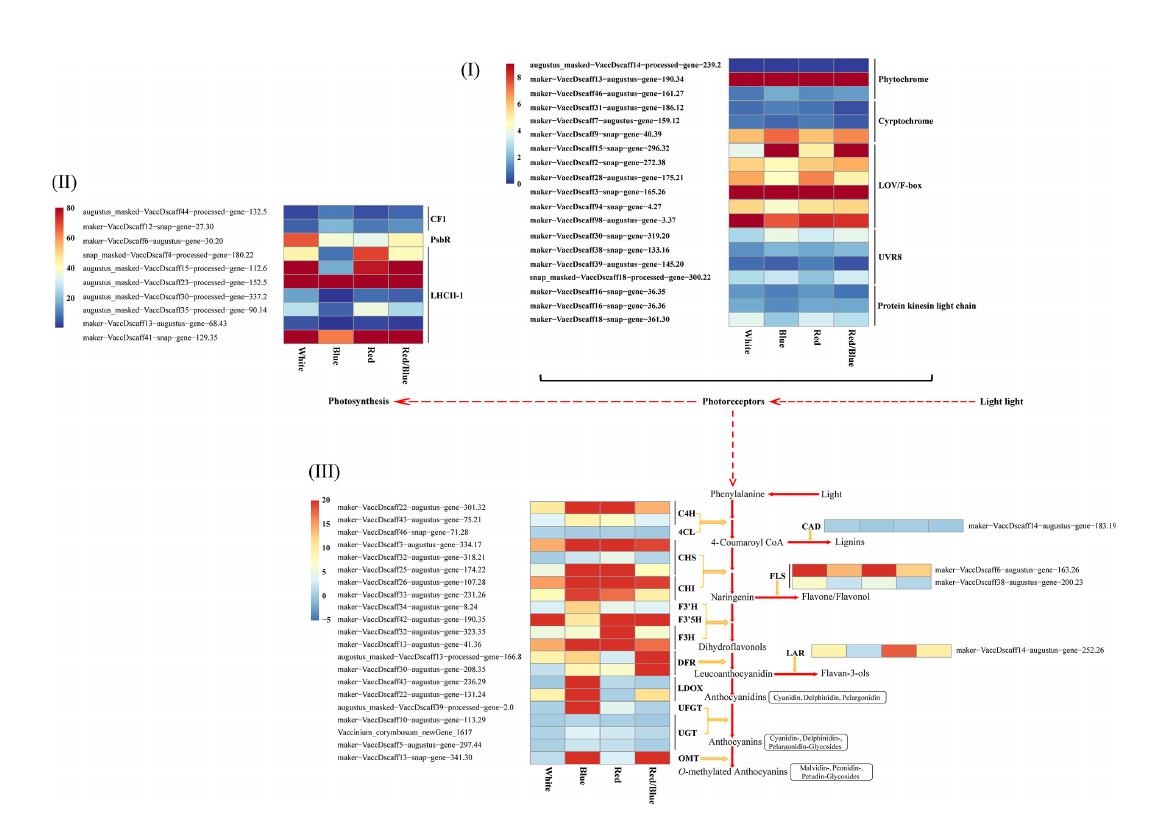
FIGURE 3 Expression heatmap showing the differentially expressed genes related to photoreceptor, photosynthesis, and anthocyanin and fl avonoid biosynthesis pathway under different light qualities for the blueberry leaf. (I) Differential expression of the genes related to the photoreceptor, including phytochrome, cryptochrome, LOV/F-box, UVR8, and protein kinases in the light chain; (II) Expression levels of the DEGs from CF1, PsBR, and LHCII-1; (III) Expression patterns of the DEGs involved in the anthocyanin and fl avonoid biosynthesis pathway. Enzyme names and expression levels are shown at the side of each step. C4H, cinnamate 4- hydroxylase; 4CL, 4-coumarate:CoA ligase; CHS, chalcone synthase; CHI, chalcone isomerase; OMT, O -methyltransferase; F3 ′ H, fl avonoid3 ′ -monooxygenase; F3 ′ 5H, fl avonoid 3 ′ , 5 ′ -hydroxylase; DFR, dihydro fl avonol-4-reductase; LDOX, leucoanthocyanidin dioxygenase; LAR, leucoanthocyanidin reductase; UFGT, UDP- glucose fl avonoid glucosyltransferase; UGT, anthocyanidin 3-O-glucoside 5-O-glucosyltransferase; CAD, cinnamyl alcohol dehydrogenase; FLS, fl avonolsynthase; Red and blue, respectively, indicated high and low expression according to the color bar using the unit variance scaling